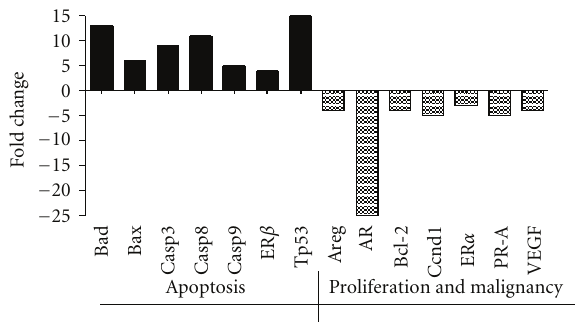
Figure 5: Expression of proapoptosis and di ff erentiation genes in tumors. Seven-week-old female Lewis rats were treated with a single IP injection of 50 mg/kg MNU. Tumors developed for 90 days, prior to treatment ( n = 10) for 14 days with cyclodextrin vehicle daily, or 6.6mg HE3235 daily. Gene expression was measured by RT- PCR. The graphs showratiosof gene expression in HE3235 (6.6mg) treated tumor samples relative to vehicle treated, normalized to β - actin. Amphiregulin (Areg), androgen receptor (AR), tumor protein 53 (p53), Bcl2 antagonist of cell death (Bad), apoptosis regulator BAX (bax), B-cell CLL/lymphoma 2 (Bcl-2), caspase 3 (Casp3), caspase 8 (Casp8), caspase 9 (Casp9), Cyclin D1 (Ccnd1), estrogen receptor alpha (ER α ), estrogen receptor beta (ER β ), progesterone receptor isoform A (PR-A), and vascular endothelial growth factor (VEGF). HE3235 treatment upregulates proapoptotic genes in tumors and downregulates tumor proliferation and malignancy